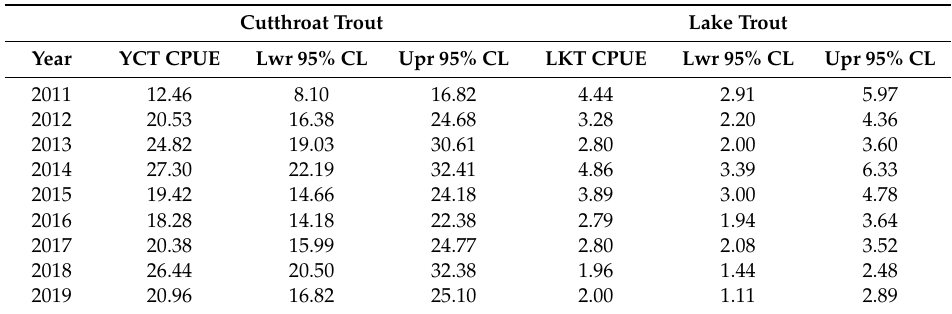
Table A4. Mean catch-per-unit-e ff ort (CPUE, 100-m net night) of cutthroat trout and lake trout during annual long-term gillnetting assessments on Yellowstone Lake, 2011–2019, with lower (Lwr) and upper (Upr) 95% confidence limits (CL).